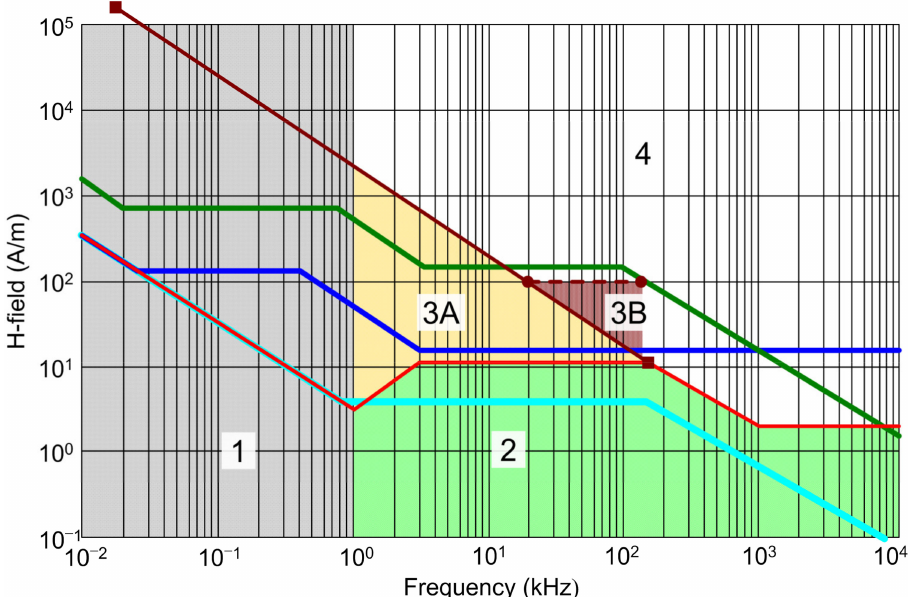
Figure 6. Comparison of exposure reference levels for the general public (ICNIRP 1998 light blue, ICNIRP 2010 blue, IEEE C95.1 green) and immunity test levels in ISO 14117 (interference red, malfunction brown). The labeled regions correspond to [70]: (1) normal sensing and operation levels for PMs and ICDs; (2) PM/ICD operation unaffected; (3A) various types of interference depending on PM/ICD type and settings, but no permanent malfunction; (3B) undefined interference, but no permanent damage; (4) possible permanent